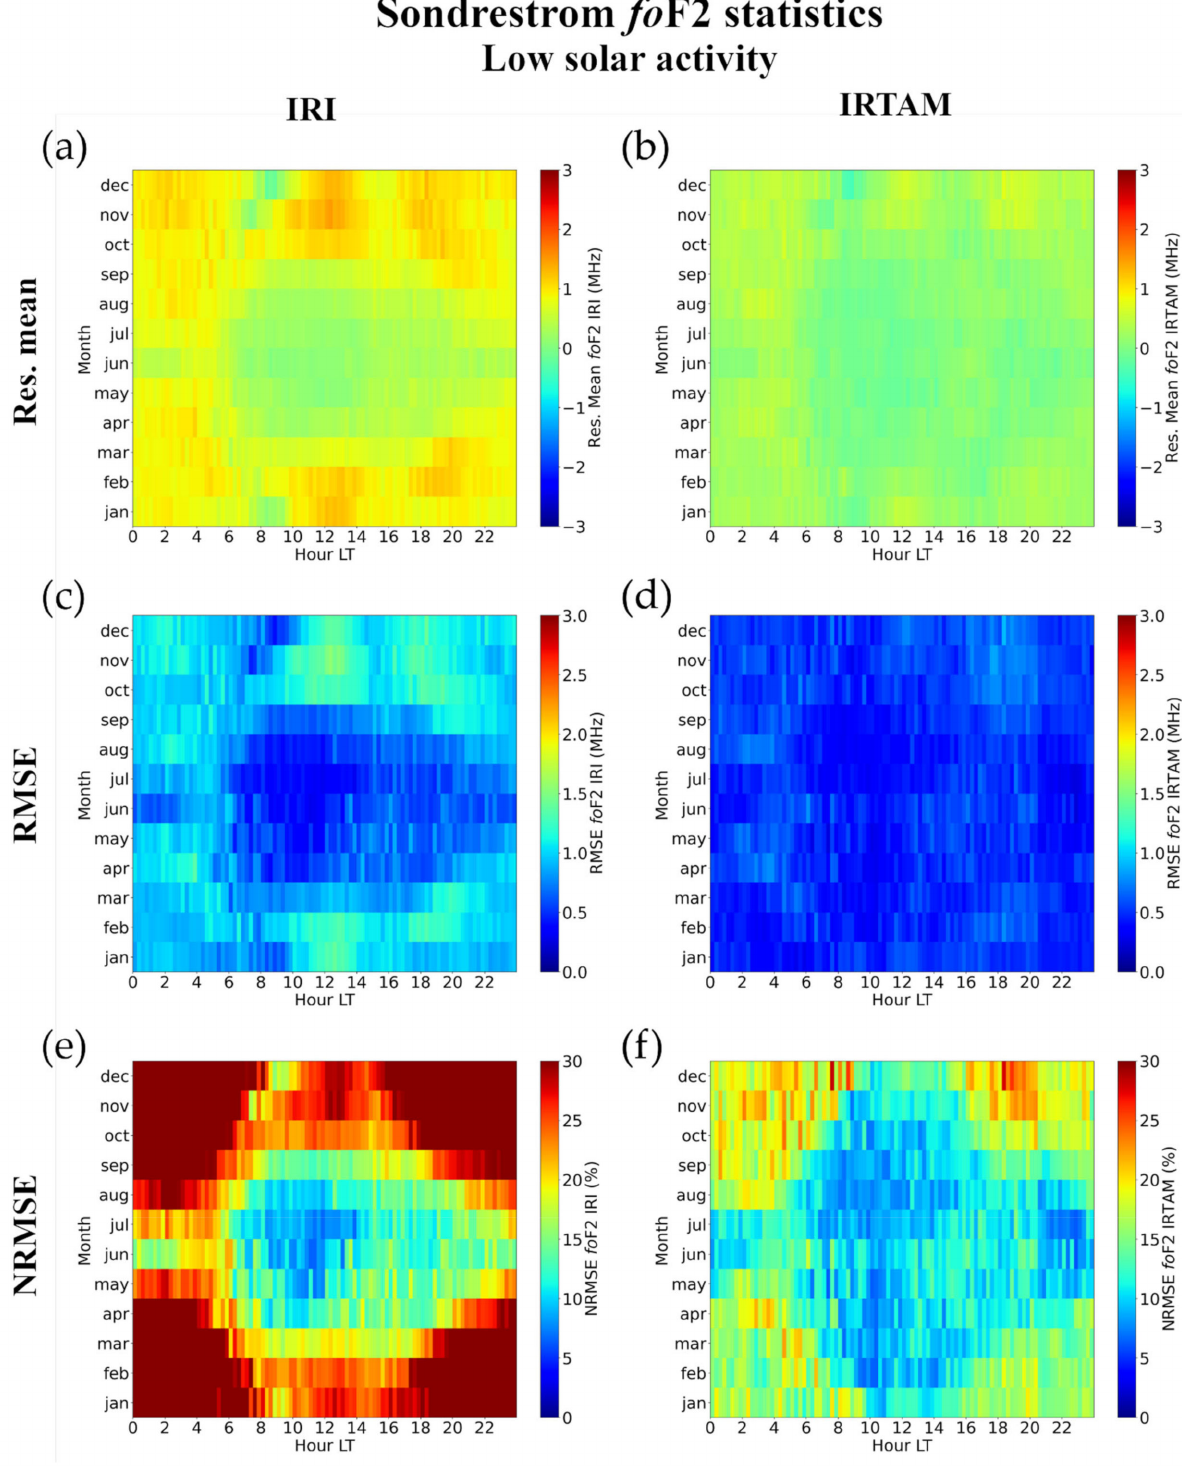
Figure 13. Same as Figure 4 but for